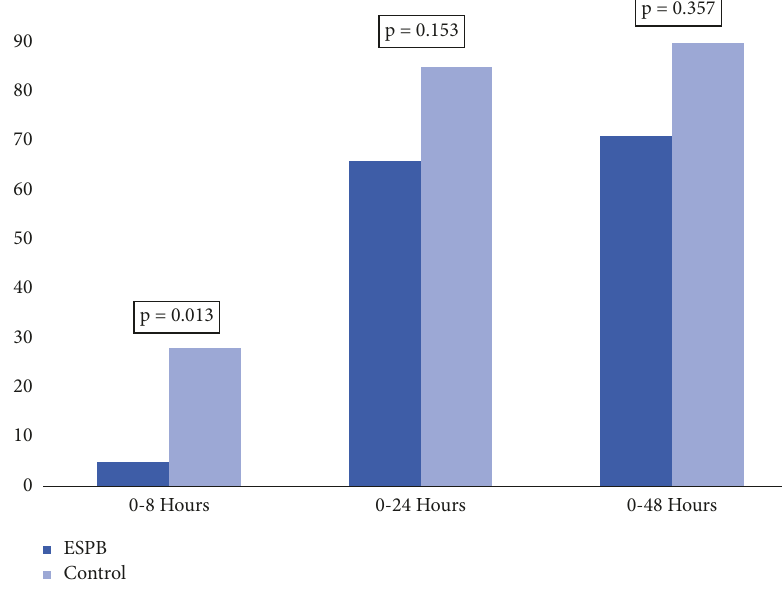
Figure 3: Postoperative opioid consumption.